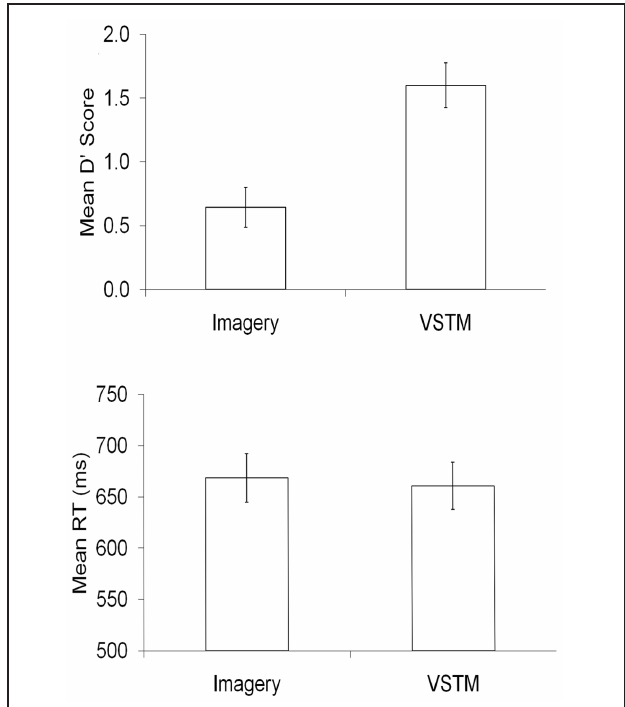
FIGURE 3 | The behavioral data, in terms of d prime and mean reaction times (RT), for each condition within the experimental task.